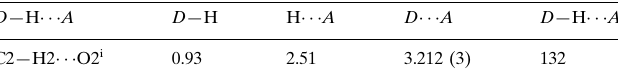
Hydrogen-bond geometry (A˚ , (cid:1)